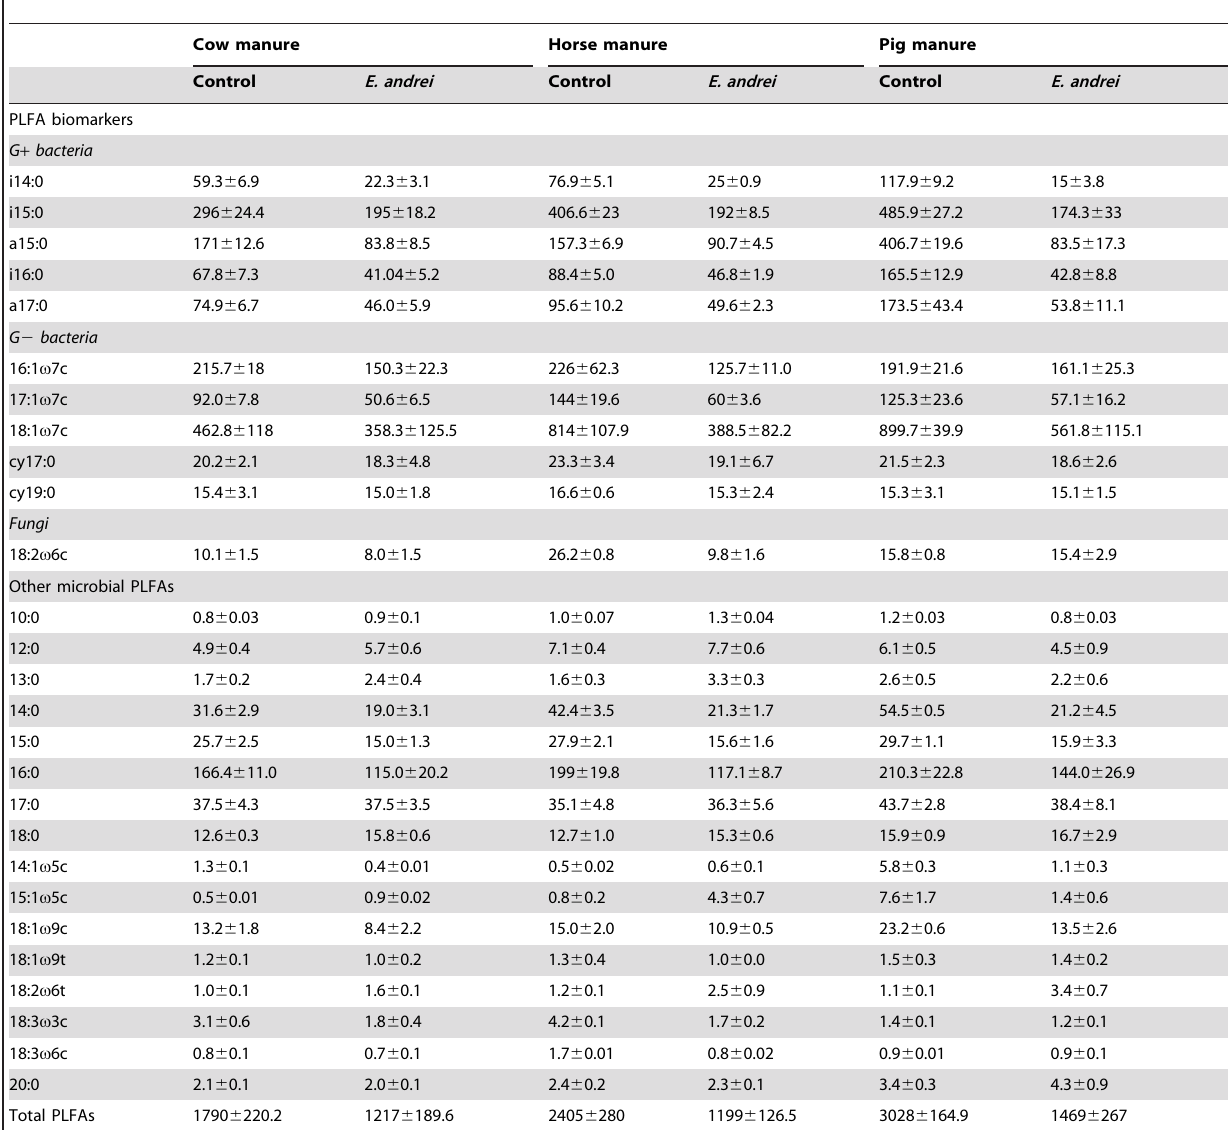
Table 1. PLFA yields ( m g g 2 1 dw) in control and cast samples derived from the three types of animal manure (cow, horse and pig).